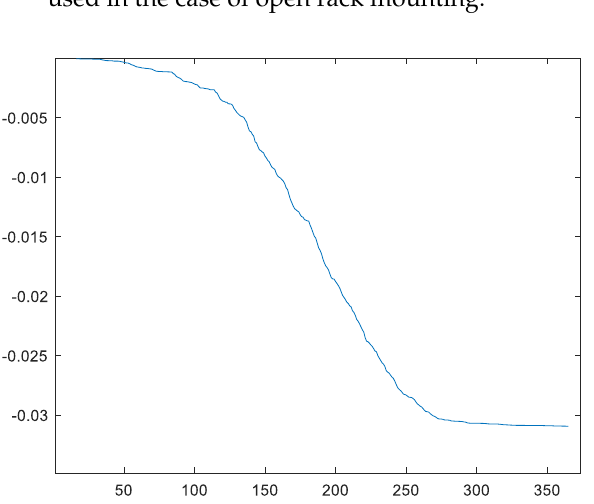
Figure 8. Onshore cumulative effect of environment on degradation over one year.